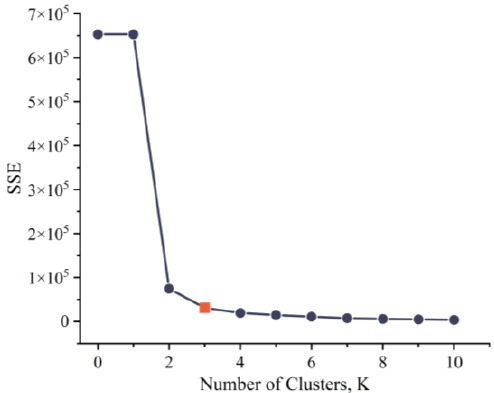
Figure 5. The number of clusters, using the SSE index.